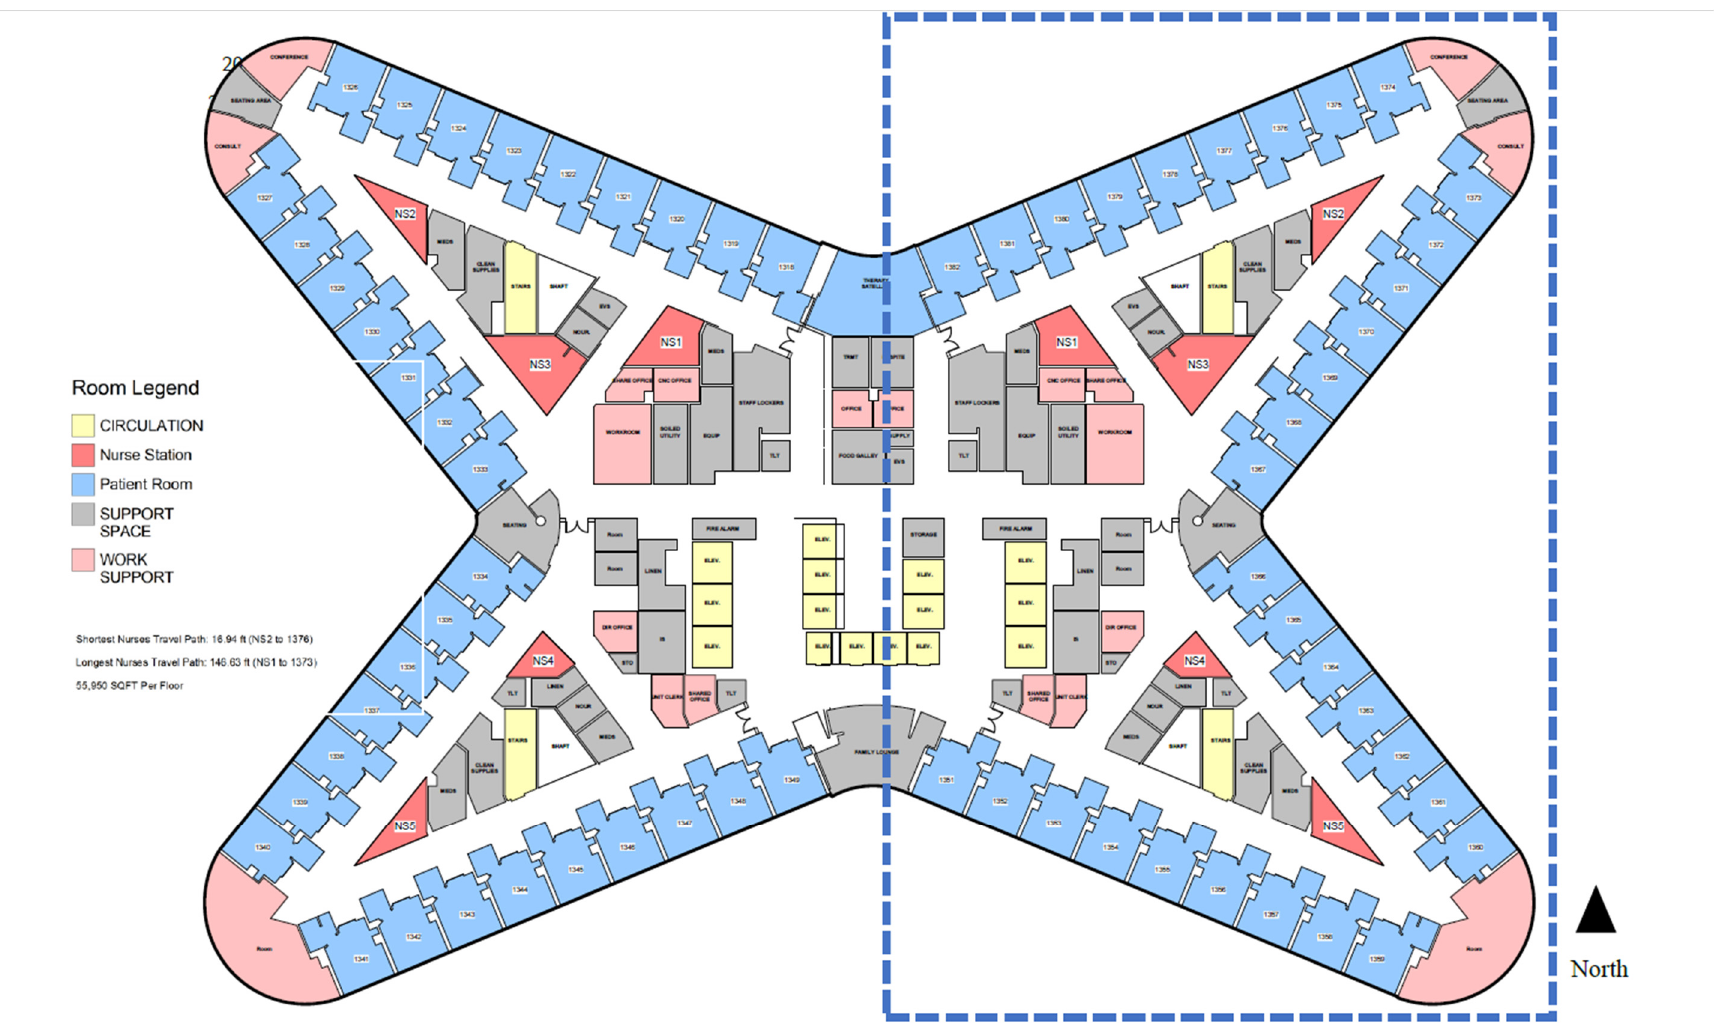
Figure 2. Floor plan of 13 East of new Tower (Image Courtesy: RUMC, designed by Perkins and Will, plan redrawn by the research team). Please see the dotted lines for area related to study and the drawing is not to scale.